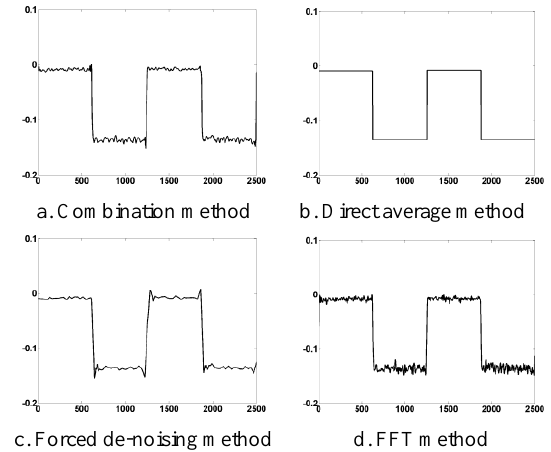
Figure 4. Comparison of different de-noising